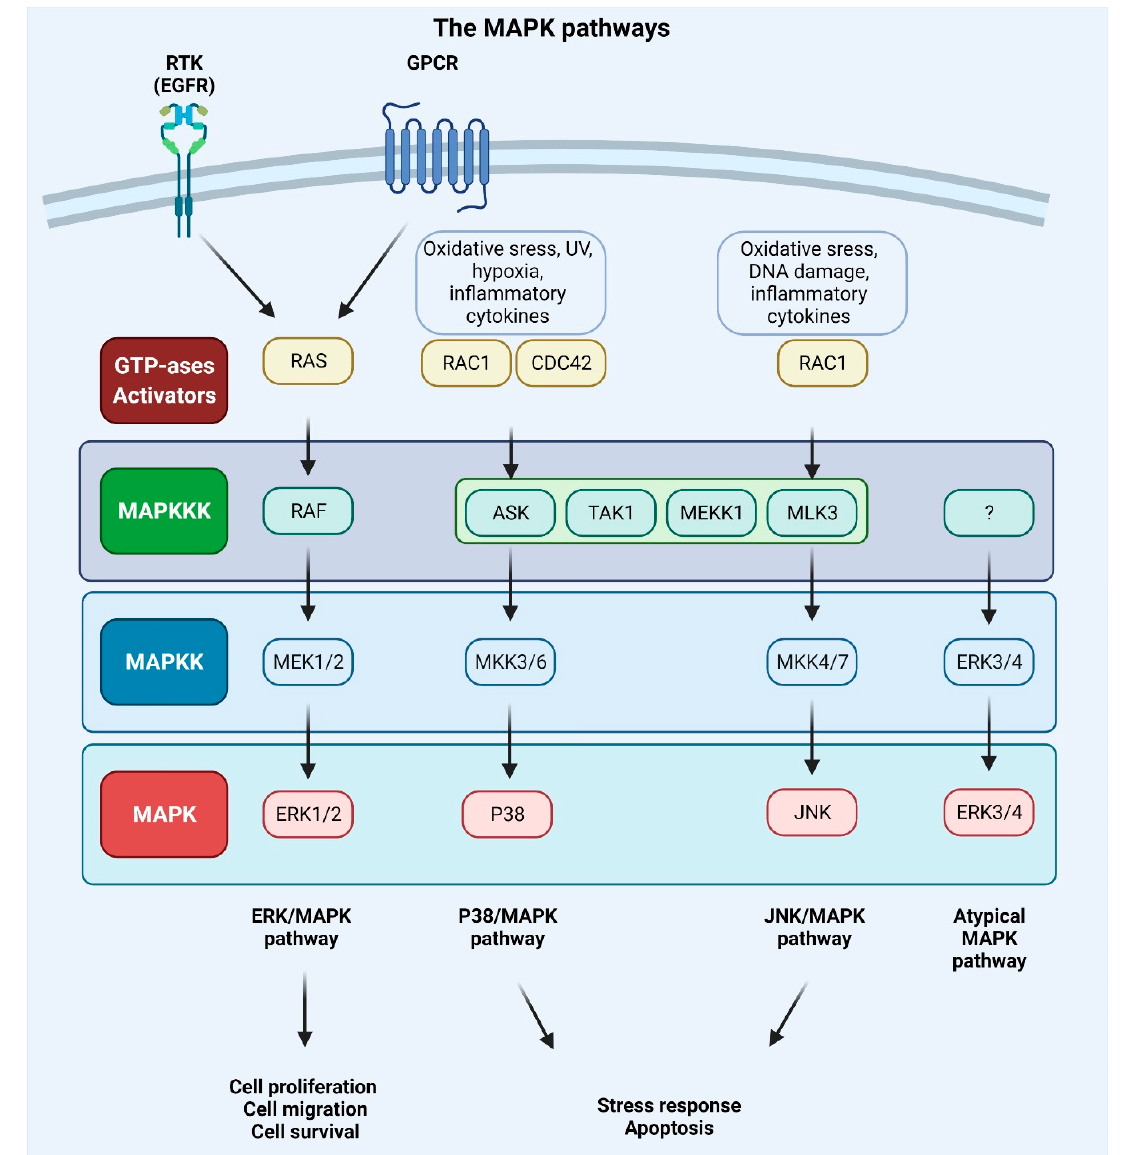
Figure 4. Mitogen-activated protein kinase (MAPK) signaling pathways. Extracellular signals such as growth factors and cytokines, as well as intracellular signals such as oxidative and DNA damage, activate MAPK pathways. GTPases (activators) such as RAS, RAS-related protein (RAC), and cell division control protein 42 homolog (CDC42) constitute the first layer of MAPK signaling cascade, which conveys the signal to downstream protein kinases. The MAPK signaling cascades consist of three kinases: mitogen-activated protein kinase kinase kinase (MAPKKK), a mitogen- activated protein kinase kinase (MAPKK), and mitogen-activated protein kinase (MAPK) and results in proliferation, migration, differentiation, survival, or apoptosis. Mammalian MAPK pathways include ERK MAPK, P38 MAPK, and JNK MAPK signaling events. ERK/MAPK pathway is activated by RAS, which is attracted to the plasma membrane through receptor tyrosine kinases (RTKs) and G protein-coupled receptor (GPCRs) activation. In this cascade, MAPK/ERK kinase 1/2 (MEK1/2) activates extracellular signal-regulated kinase 1/2 (ERK1/2). P38/MAPK and JNK/MAPK pathways are triggered by various insults that activate signaling through MKK3/6 or MKK4/7 (MAPKKs), respectively, that are activated upon MAPKKK s such apoptosis signal-regulating kinase 1 (ASK1), transforming growth factor- β -activated kinase 1 (TAK1), MEKK1 (MAPKKK), and MLK3 (MAPKKK). ERK3/4 are considered atypical MAPK kinases